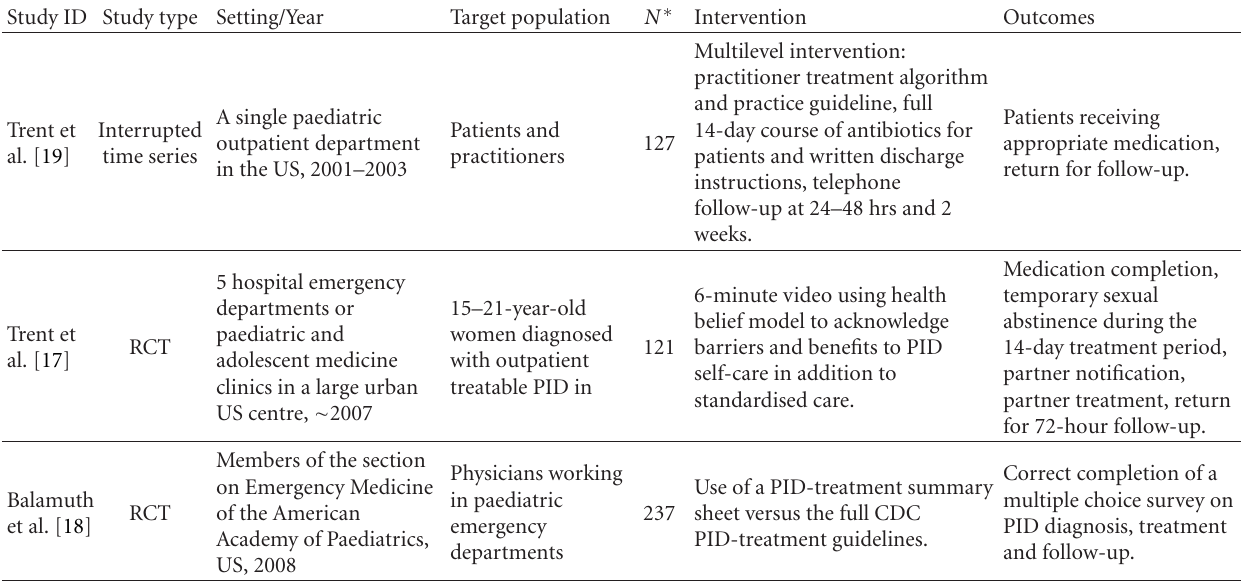
Table 1: Summary of controlled studies to improve adherence to diagnosis and management guidelines for PID. Study ID Study type Setting/Year